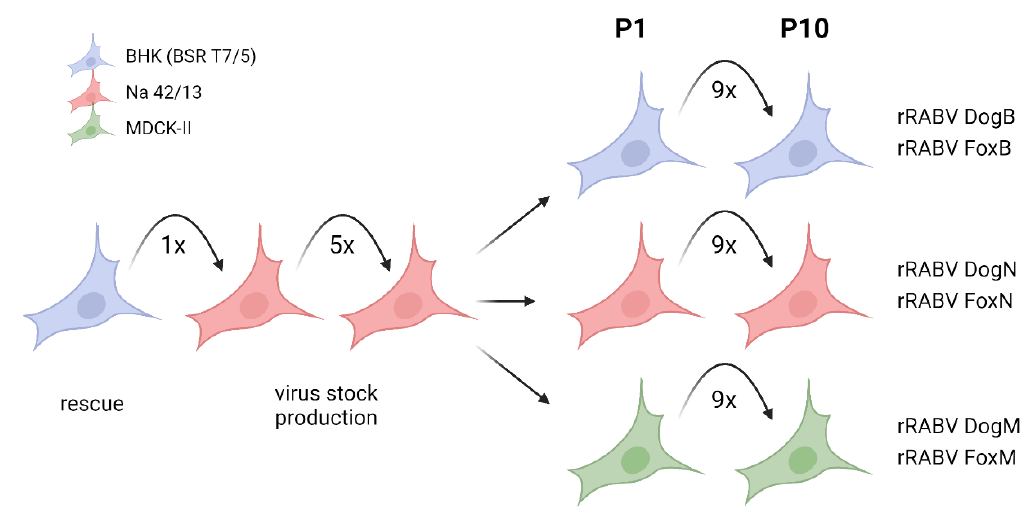
Figure 1. Passage history of the recombinant virus clones rRABV Dog and rRABV Fox. After rescue of the recombinant virus clones rRABV Dog and rRABV Fox in BSR T7/5 cells, five successive supernatant virus passages were performed on Na 42/13 for virus stock preparation. The viruses were then serially passaged ten times (P1–P10) on BHK (BSR T7/5), Na 42/13, or MDCK-II cells. Dependent on the respective cell line, a suffix was added to the resultant viruses’ designation (B/N/M = passage history on BHK/Na 42/13/MDCK-II cells).